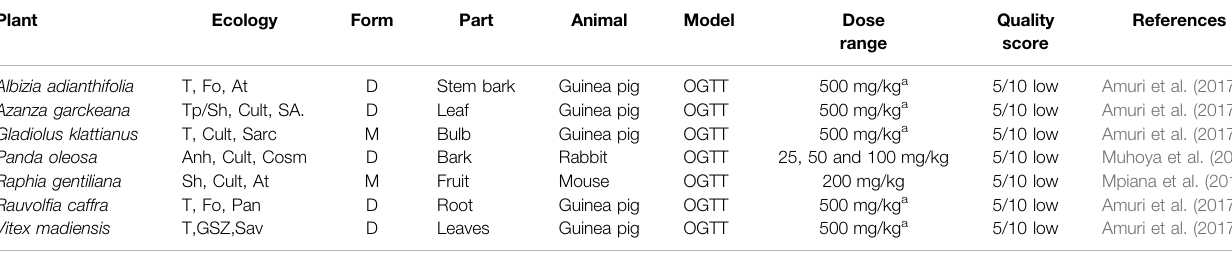
TABLE 4 | Local plants studied for antidiabetic effect in animals.